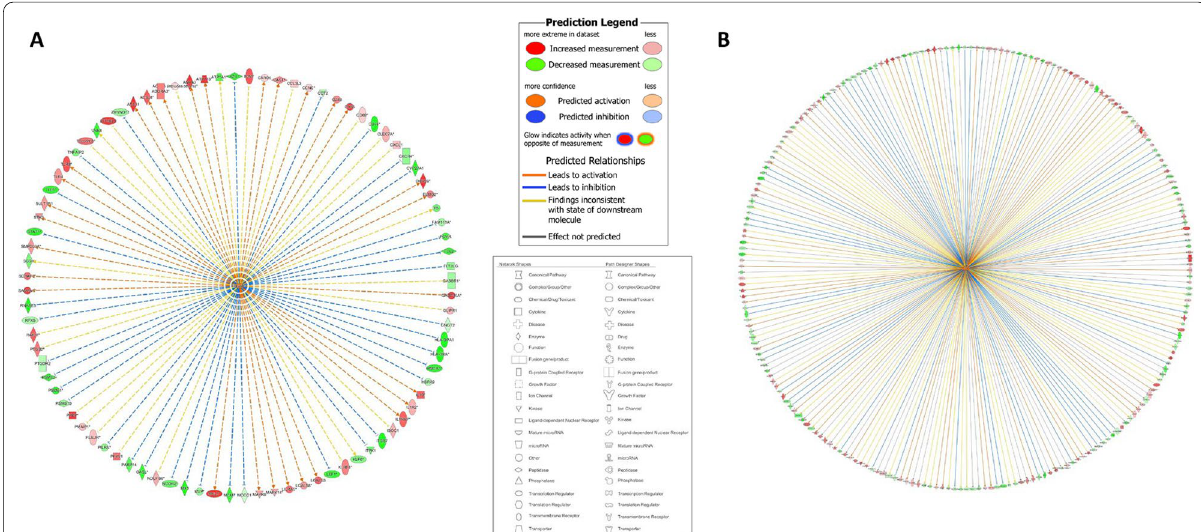
1.36 x 10 –7 and = 1.55 x 10 –8 and Z-score 4.064. Different shapes represent the molecular = =